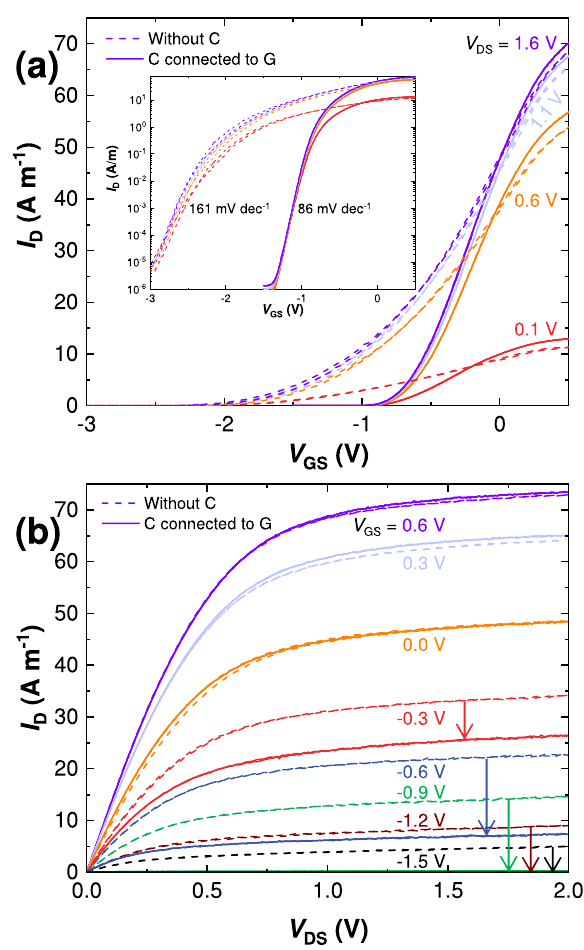
Fig. 3 The electrical characteristics of a dual-gate GESFET without the control gate (dashed lines) and with the control gate connected to the graphene gate (solid lines). The channel length L = 1.5 μ m and width W = 4.8 μ m. a The transfer curves of the GESFET where the drain current I D (normalized by the channel width W ) is measured as a function of V GS at V DS ranging from 0.1 to 1.6 V with a step of 0.5 V. The inset shows the same transfer curves in the semi-log scale and the corresponding subthreshold swings. b The output curves of the same dual-gate GESFET with I D measured as a function of V DS at V GS ranging from − 1.5 to 0.6 V with a step of 0.3